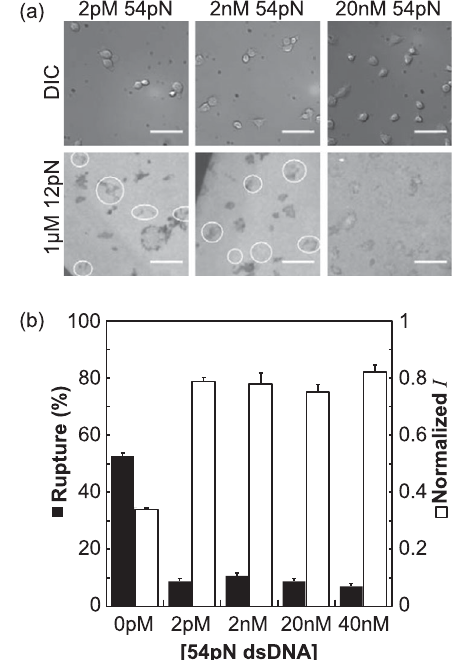
FIG. 5. Weak tether transformation vs strong TGT concen- tration. (a) Representative images of MP TGT surfaces. DIC (top) and fluorescence loss of the weak TGT (bottom). The white outlined regions in the bottom images correspond to adhered cells in the top images. Scale bars are 50 μ m. (b) Percent rupture and normalized rupture moment ( I ) are measured and averaged for cells vs strong TGT concentration. Error bars denote standard errors of mean.